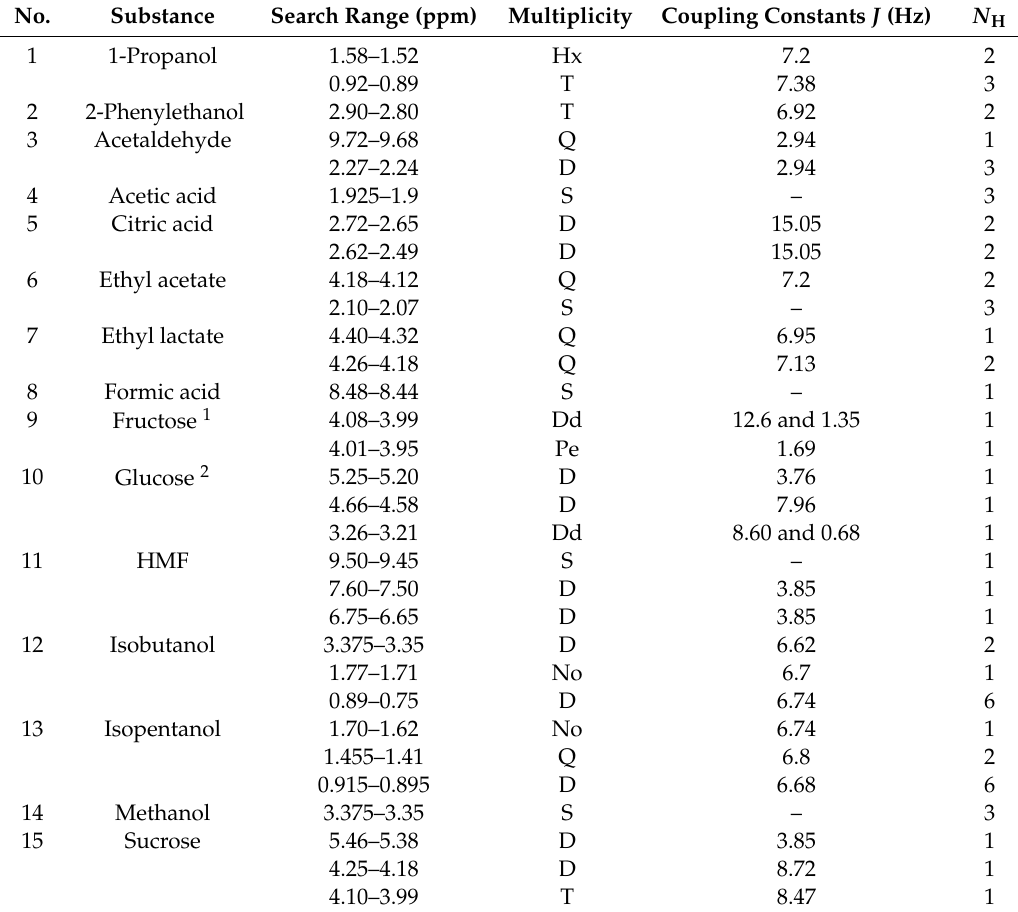
Table 3. Characteristic NMR signals of the analytes in spirit drinks.